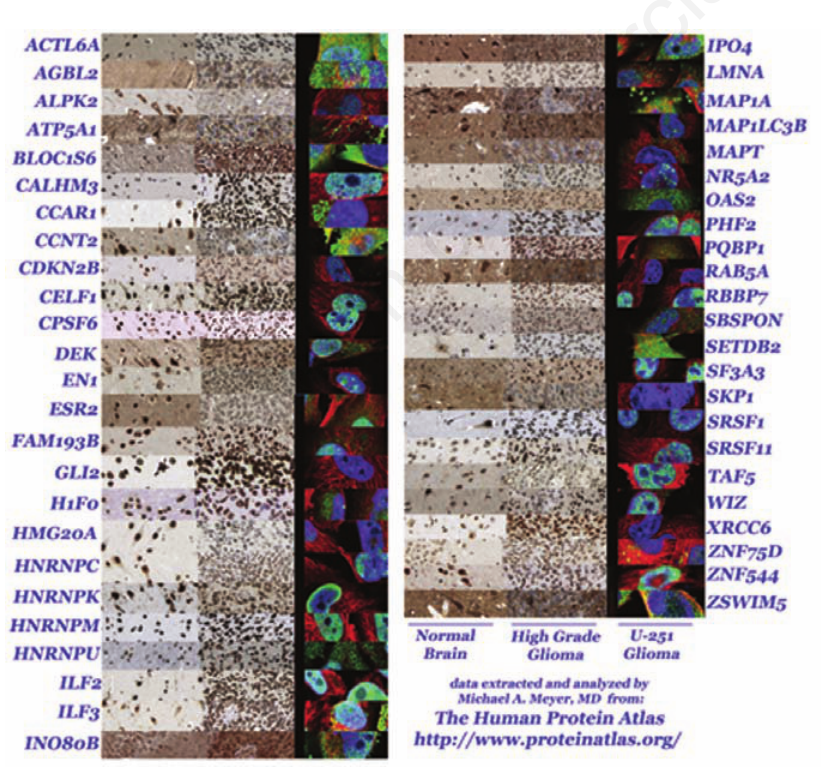
Figure 1. Montage of 48 genes selected from the Human Protein Atlas that display strong staining of normal brain tissue (left column) and also have both immunohistochemical data available for surgical resections of high grade gliomas from individual patient cases (mid- dle column) and immunofluoresence data from the U-251 glioma cell line (right